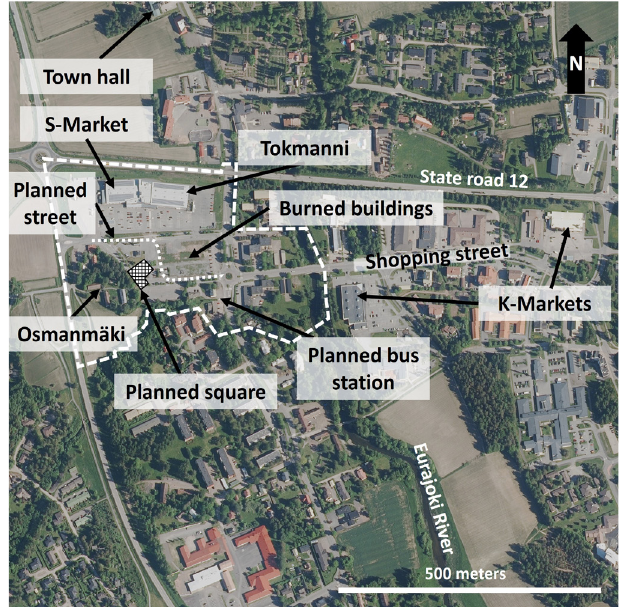
Fig. 2. Planned area of Eura downtown (Background: Maanmittauslaitos Ortokuva